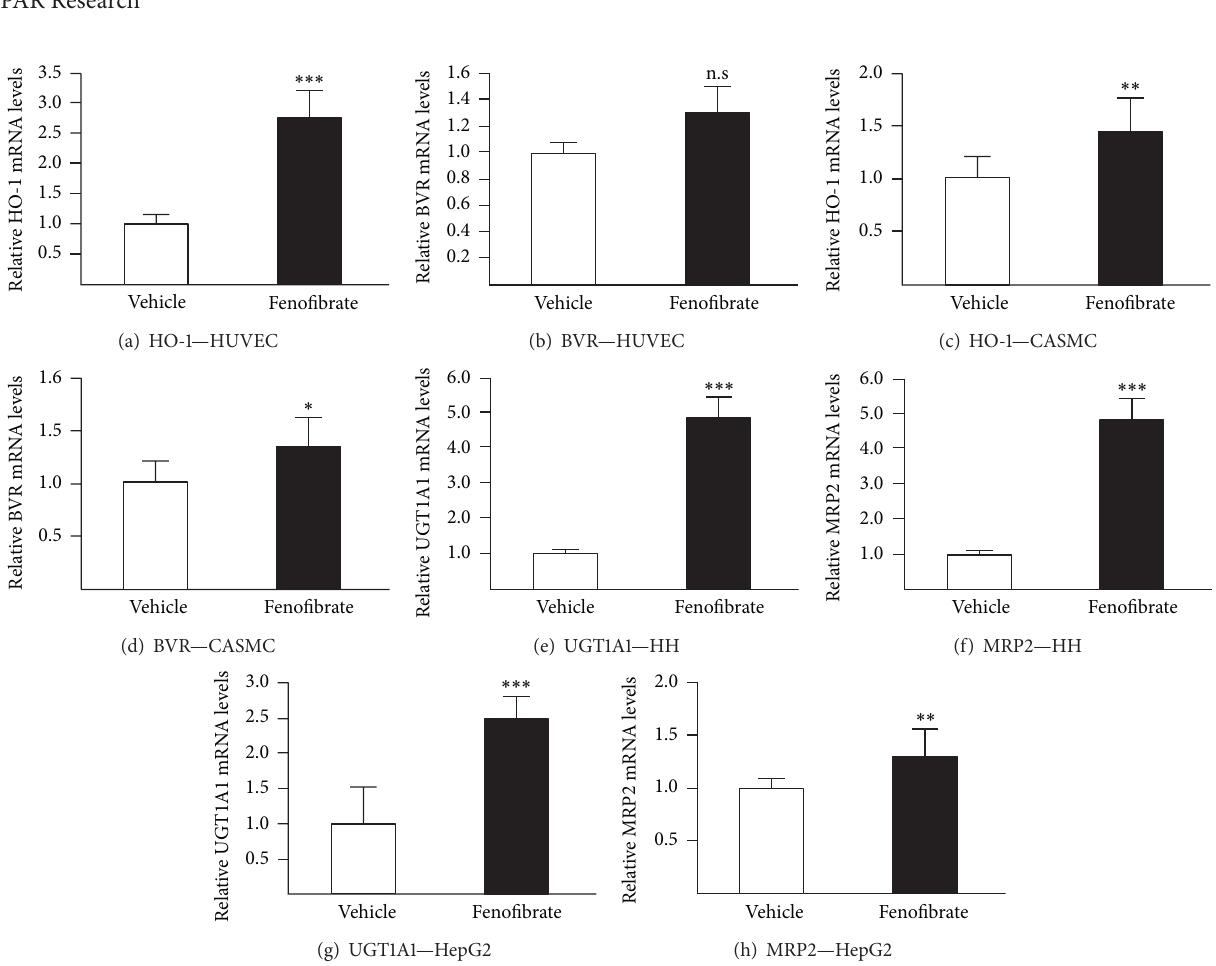
samples from control cells (vehicle) (Figures 4(b) and